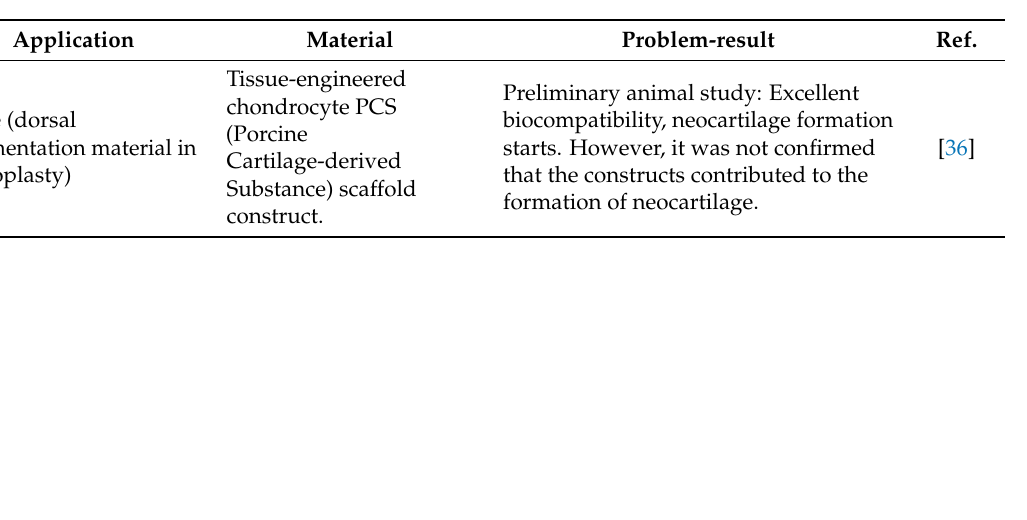
Table 1. Scaffolds in clinical and preclinical use for cartilage regeneration.